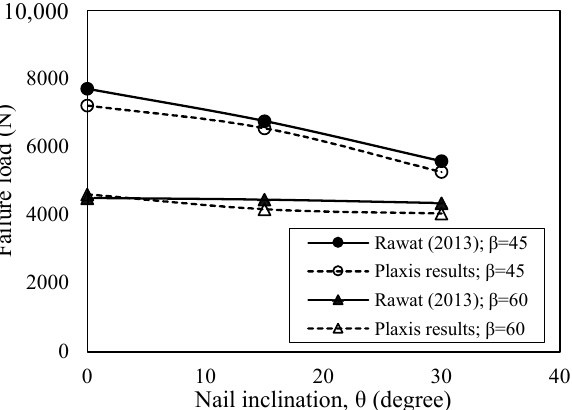
Figure 13. Comparison of failure load of a physical model with nail inclination for measured results.